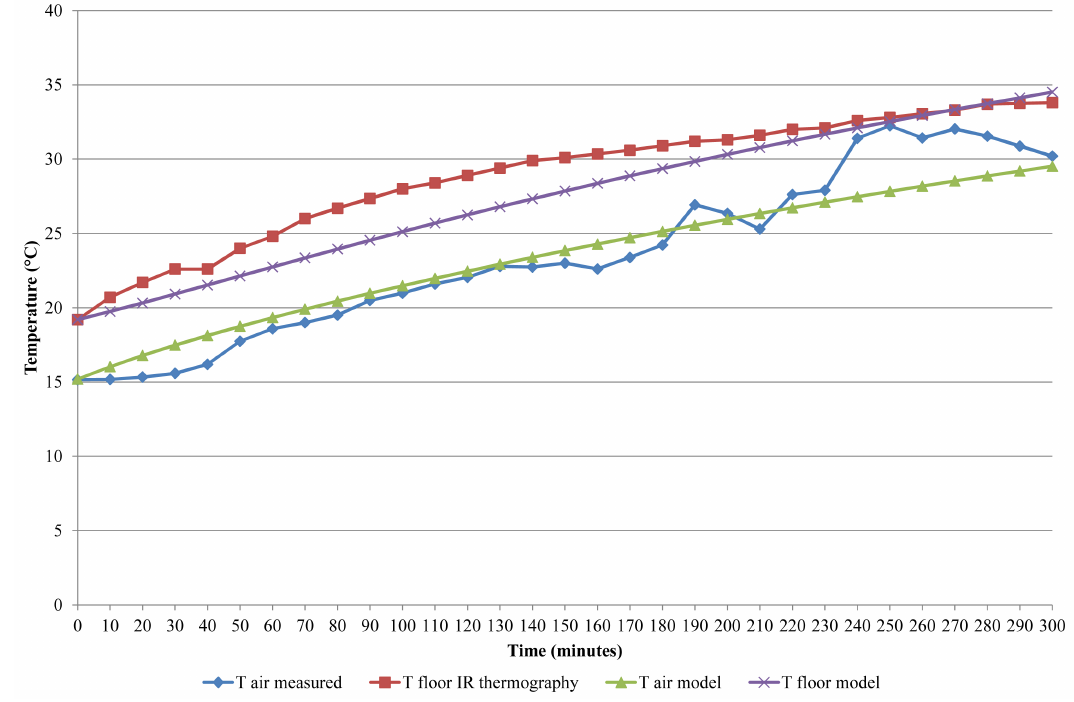
Figure 6. Comparison between calculated and infrared (IR) camera retrieved results.